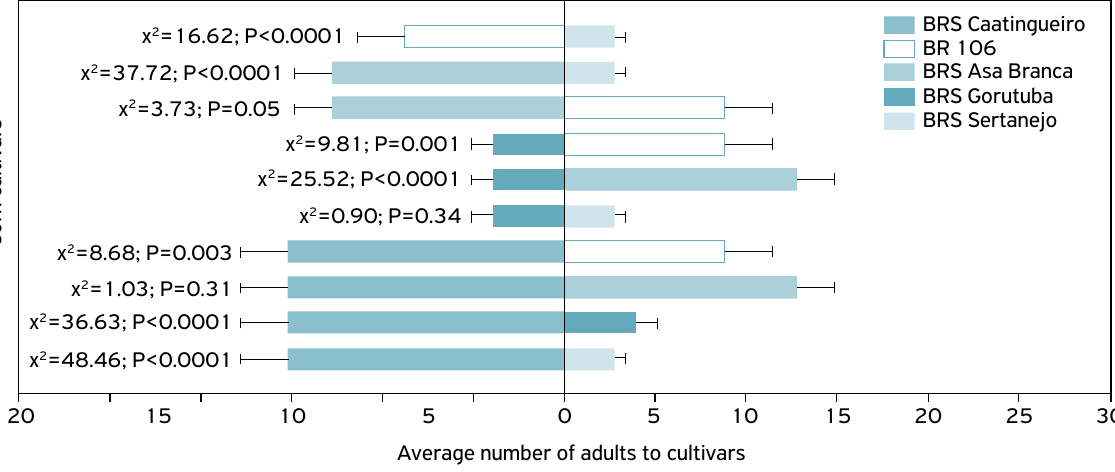
Figure 2. Preference of the adult Sitophilus zeamais (n = 435) of commercial cultivars of maize seeds. Statistically significant by c 2 test.